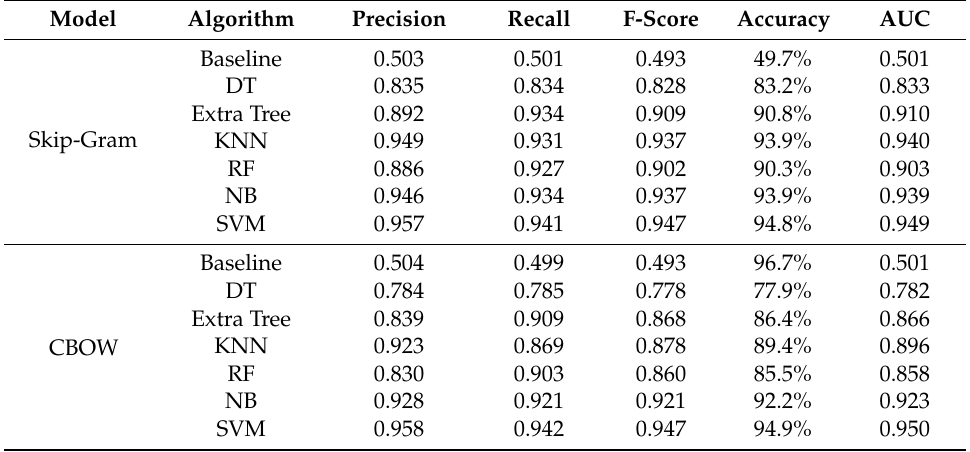
Table 17. Summary of classification algorithms with entity embedding model on training dataset.